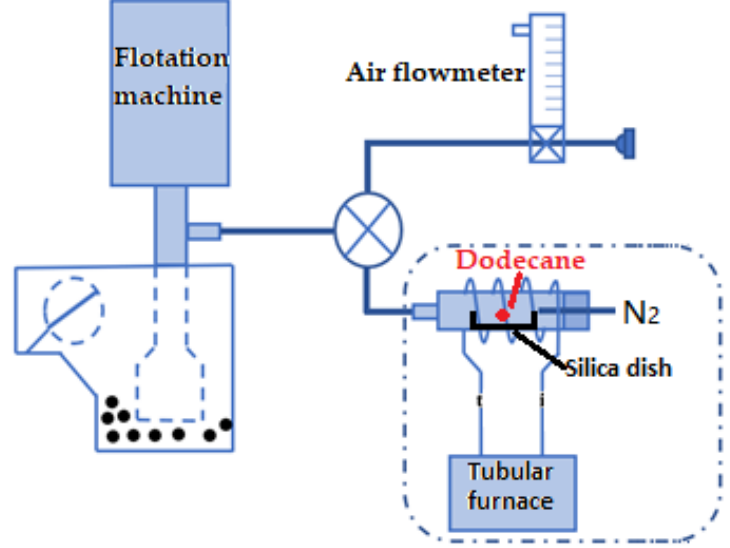
Figure 1. Diagram of the collector gasification flotation method.